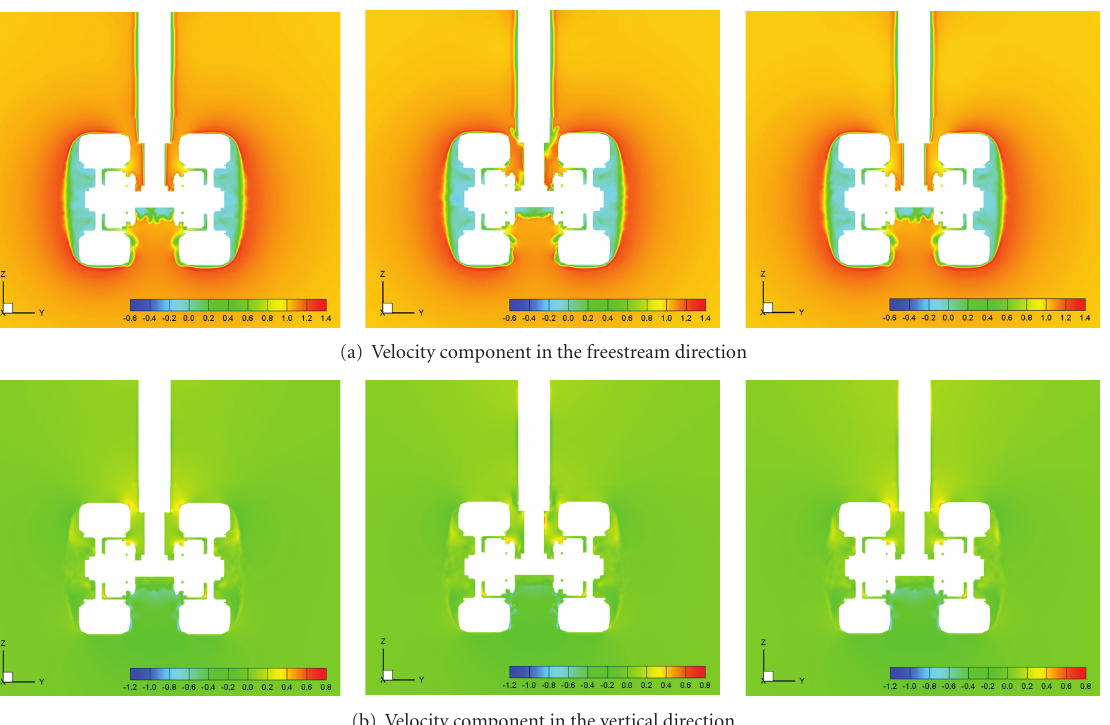
Figure 14: Computed mean velocity component at cross section x = 0 . 0 (left: BACK TEAR, center: FRONT TEAR, right: NO TEAR).